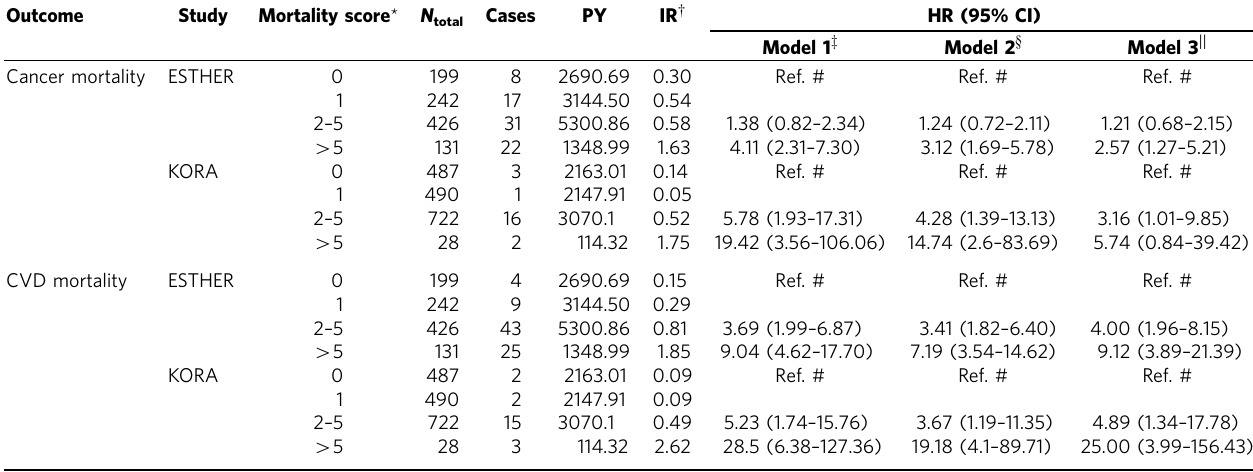
Table 4 | Associations of the risk score with cancer and CVD mortality in the ESTHER and KORA study. Outcome